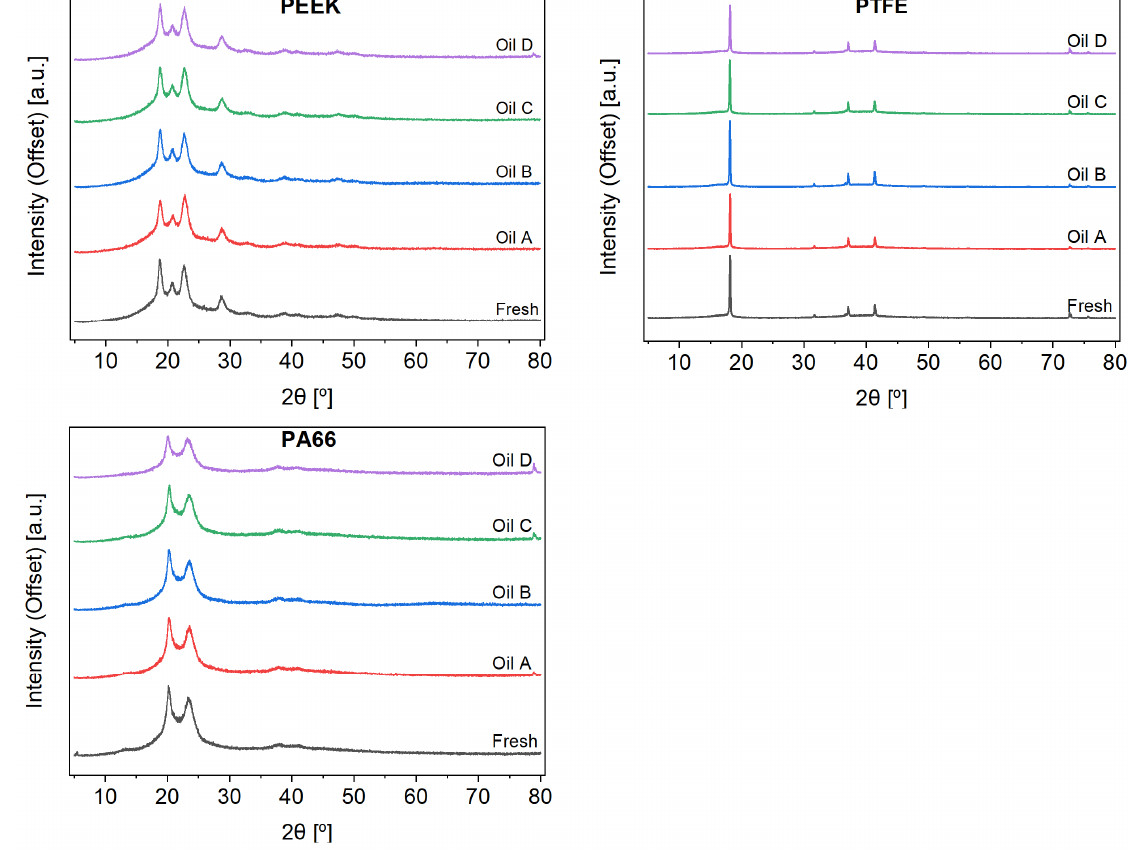
Figure 5. XRD spectra for the polymers (fresh, after 168 h, and after 672 h) in the ATFs.